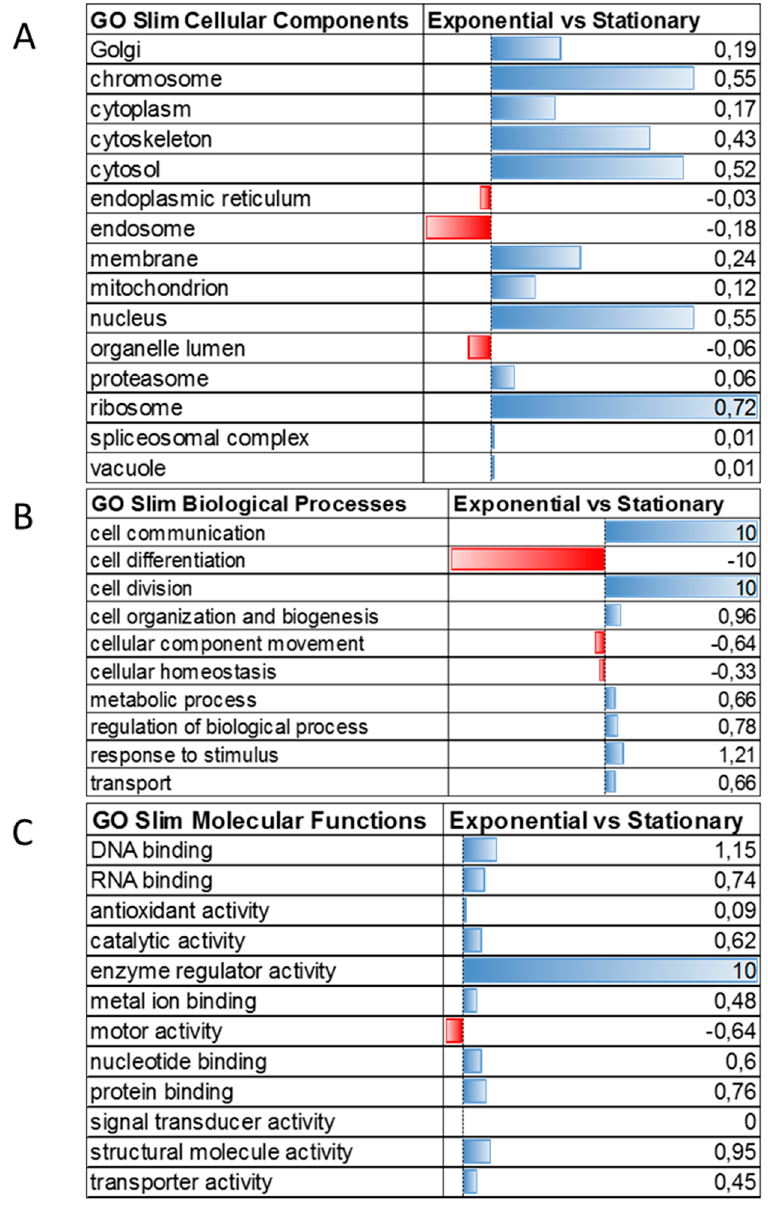
Figure 6. Gene ontology analysis combined with quantitative data of proteins differentially expressed between T. cruzi exponential and stationary phases. ( A ) Cellular components, ( B ) Biological processes and ( C ) Molecular functions of regulated proteins. Blue bars represent proteins upregulated in the exponential phase, while red bars represent proteins upregulated in the stationary phase.